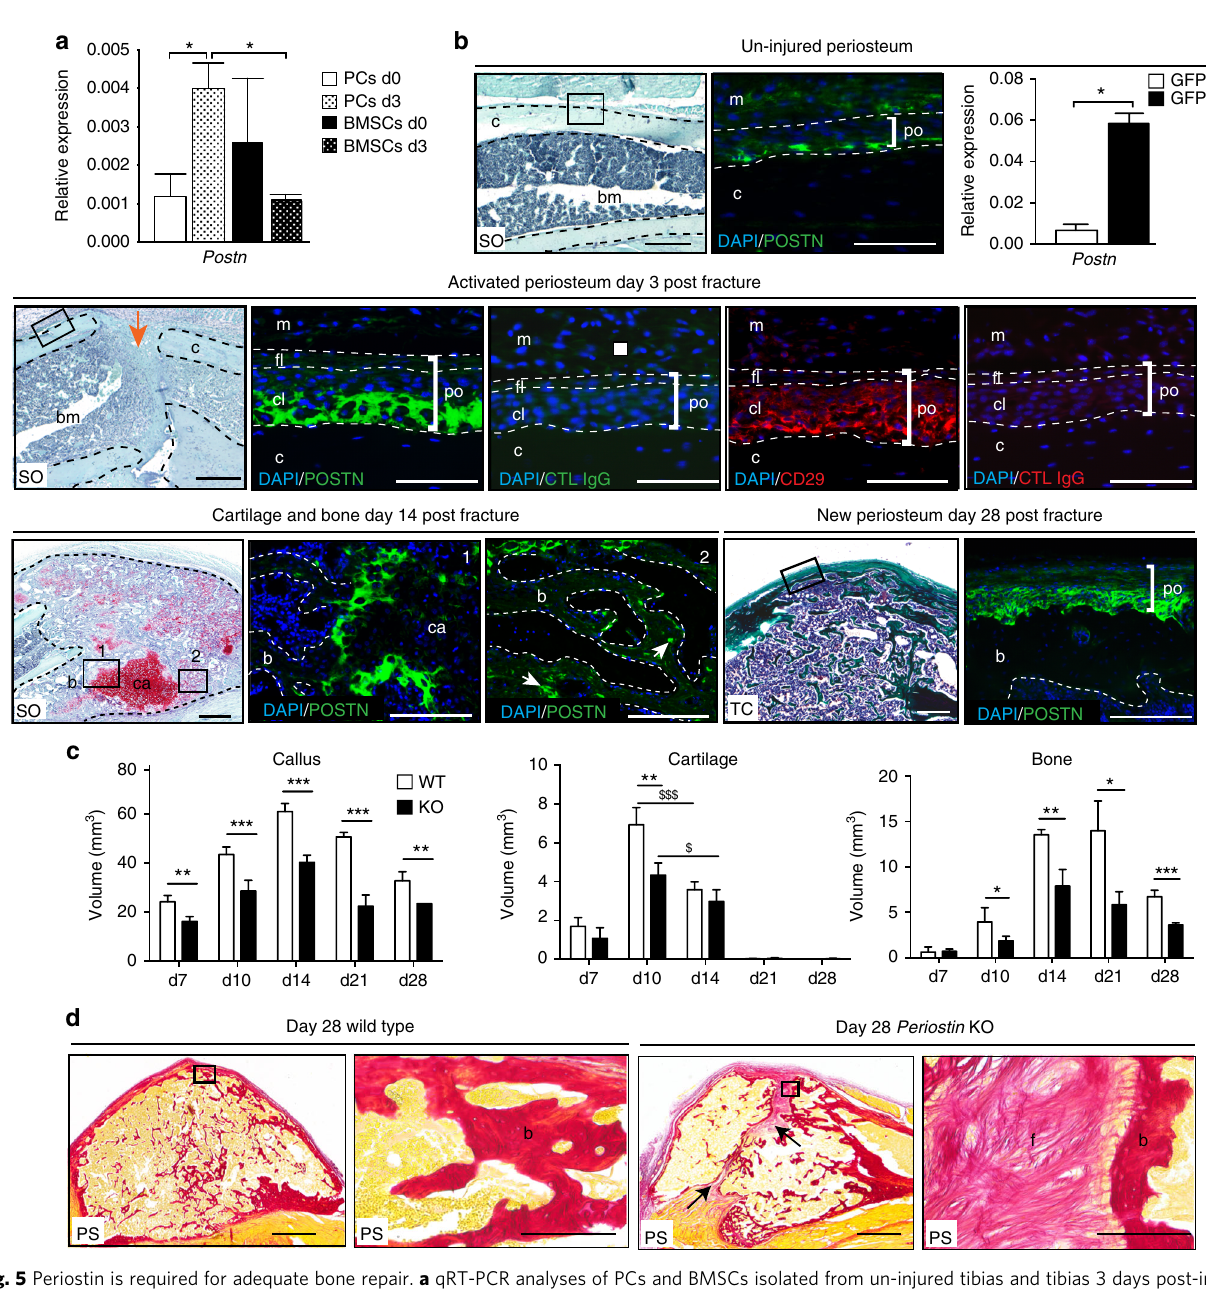
Fig. 5 Periostin is required for adequate bone repair. a qRT-PCR analyses of PCs and BMSCs isolated from un-injured tibias and tibias 3 days post-injury. Periostin ( Postn) is speci fi cally upregulated in PCs in response to injury and in PCs compared to BMSCs in response to injury. b SO staining and DAPI/ POSTN immuno fl uorescence on wild-type longitudinal tibia sections showing Periostin (POSTN) expressing cells in the un-injured periosteum near the cortex (immuno fl uorescence corresponds to box area in SO). qRT-PCR analyses show high Postn expression in Prx1-derived PCs (GFP + ) sorted from PCs cultures of un-injured hindlimbs of Prx1-Cre;mTmG mice. Three days after fracture, POSTN is highly expressed in the cambial layer (cl) of the activated periosteum (GFP) coinciding with expression of CD29 (Red). At day 14 post-fracture, POSTN is expressed in hypertrophic cartilage at the junction between cartilage and bone within the callus (box 1, GFP) and in osteoblasts within new bone trabeculae (box 2, white arrows). By day 28, POSTN expression is high in the inner layer of the newly formed periosteum at the periphery of the remodeling callus. Scale bar: 0.5 mm. c Histomorphometric analyses of callus, cartilage, and bone volumes at days 7 (d7), 10 (d10), 14 (d14), 21 (d21), and 28 (d28) post fracture in wild type (WT) and Periostin KO (KO) mice. d Picrosirius red staining (PS) on longitudinal sections of fracture callus at d28 shows absence of consolidation and fi brosis in Periostin KO mice (black arrows). Scale bar: 1 mm. SO: Safranin-O/Fast Green, TC: Masson ’ s trichrome, m: muscle, c: cortex, po: periosteum, fl : fi brous layer, cl: cambial layer,